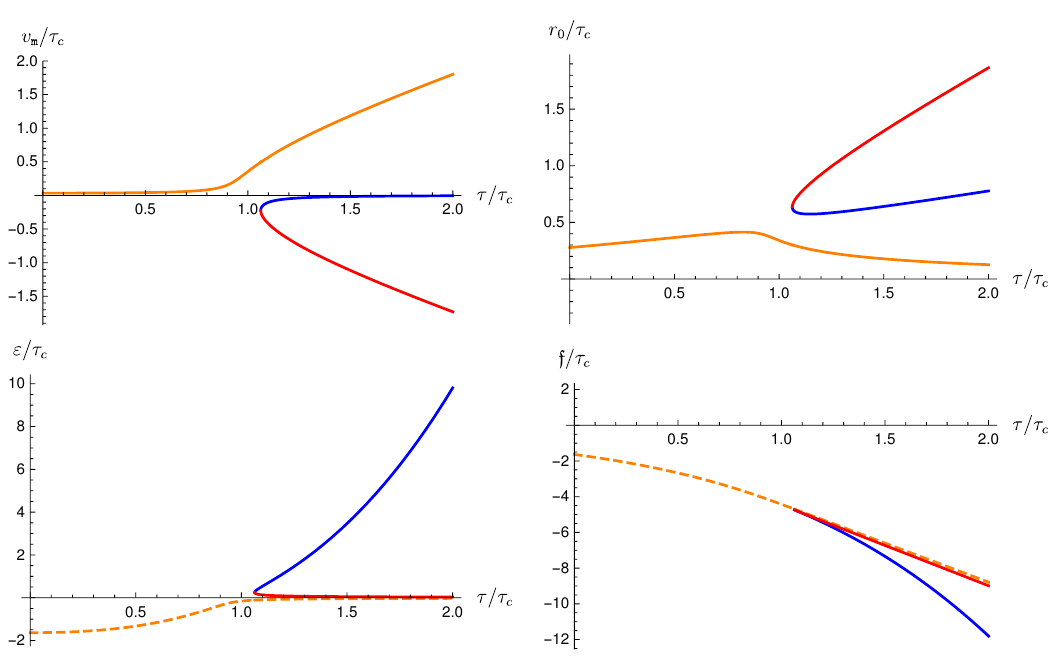
Figure 9 . Plot of the solutions of (6.24) for B = 0 : 314 B c , together with the corresponding energy " and Helmholtz free energy f densities.